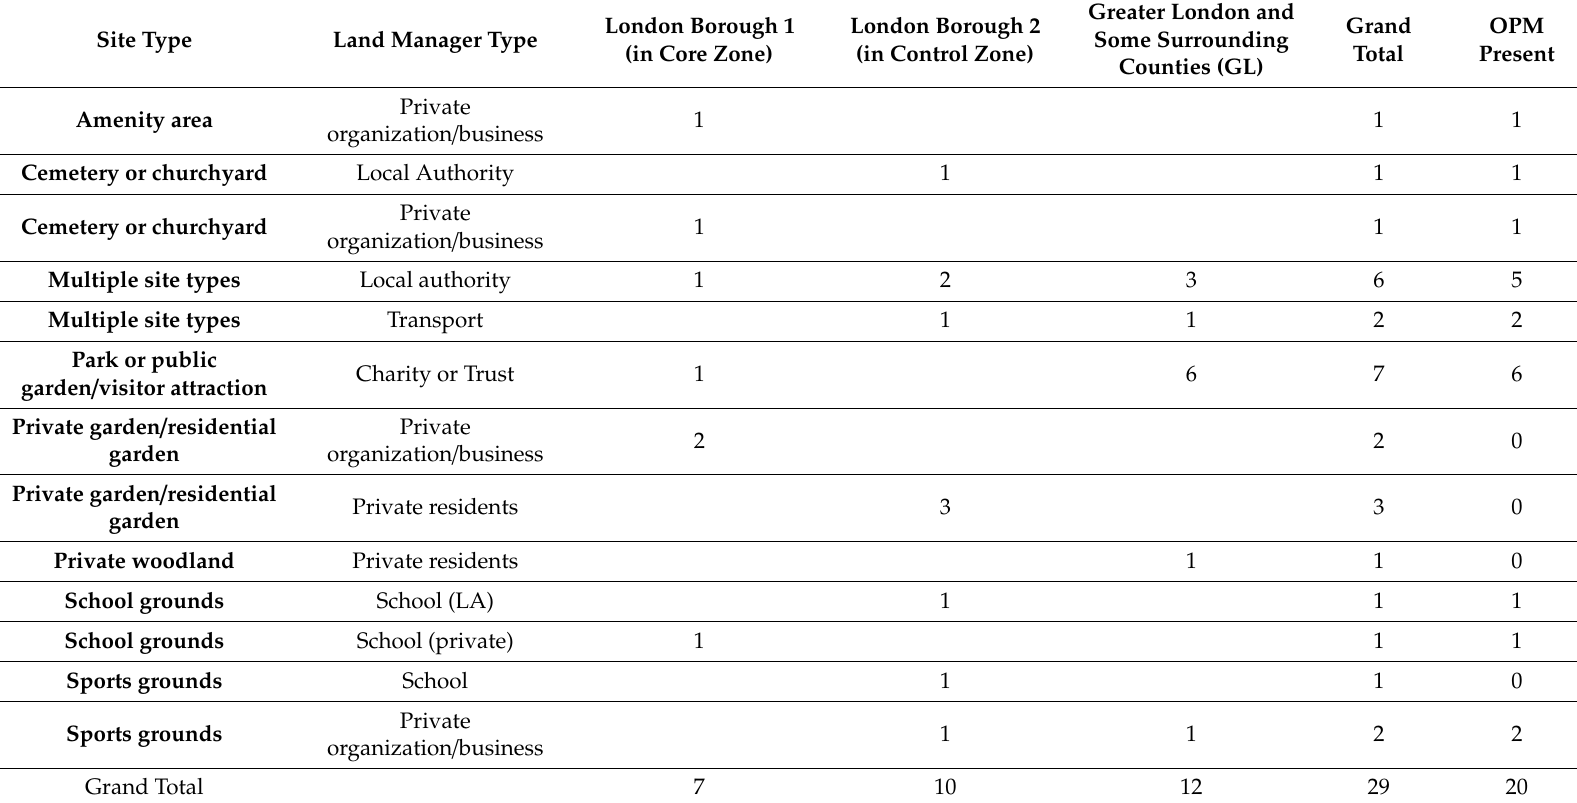
Table 1. Land managers interviewed across two London Boroughs and more generally across Greater London and in some surrounding counties. They span di ff erent site and land manager types. Most had experience of